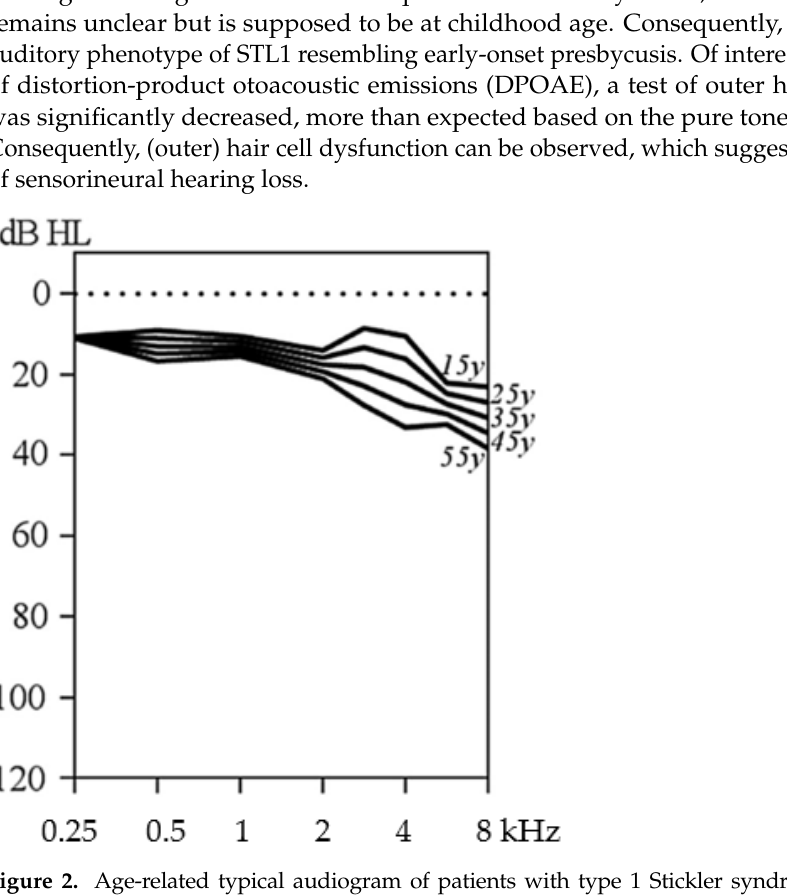
Figure 2. Age-related typical audiogram of patients with type 1 Stickler syndrome, reprinted by permission from Springer Nature: European Archives of Oto-Rhino-Laryngology [17], copyright